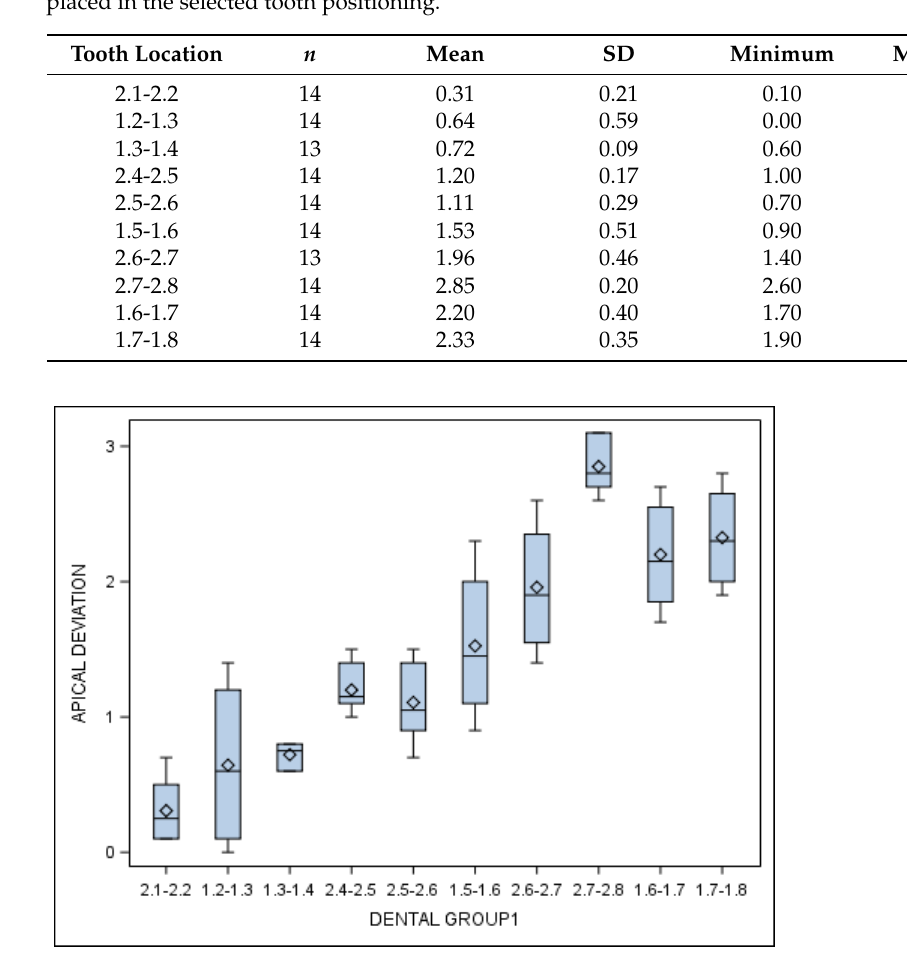
Figure 9. Box plot of the apical end-point deviations of the orthodontic micro-screws in the selected tooth positioning.